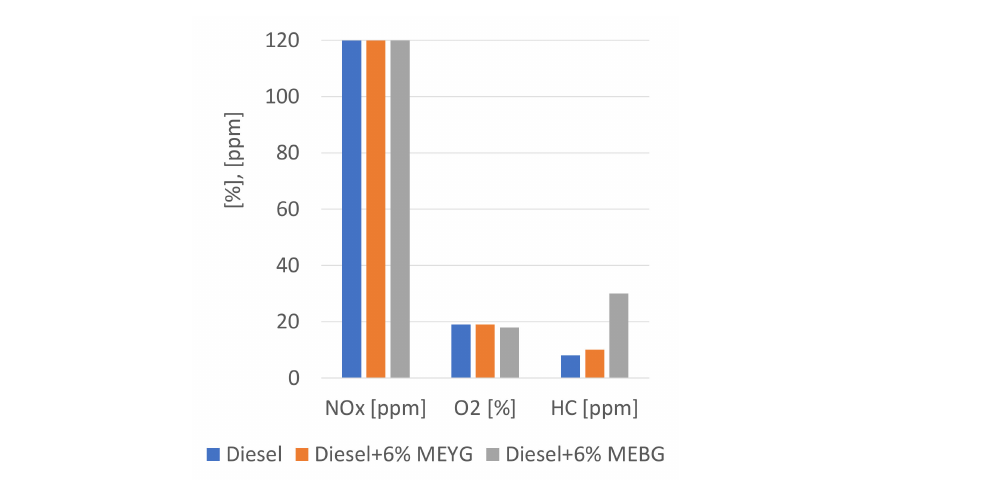
Figure 7. The engine emissions of NO x , O 2 and HC obtained at zero load of engine supplied with pure diesel, diesel with 6% of rapeseed oil methyl ester, and diesel with 6% of goose fat methyl ester, respectively.